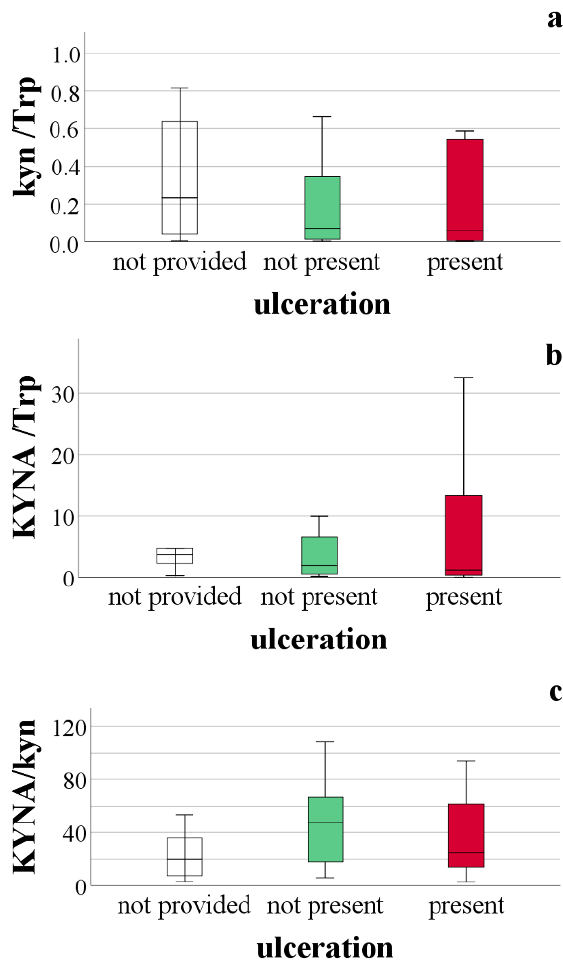
Figure 3. Comparison of kynurenine pathway metabolites based on the presence of ulceration. ( a ) comparison of kynurenine level relative to tryptophan concentration, based on the presence of ulceration, p = 0.3199; ( b ) comparison of kynurenic acid level relative to tryptophan concentration, based on the presence of ulceration, p = 0.412; ( c ) comparison of kynurenic acid level relative to kynurenine concentration, based on the presence of ulceration, p = 0.209.